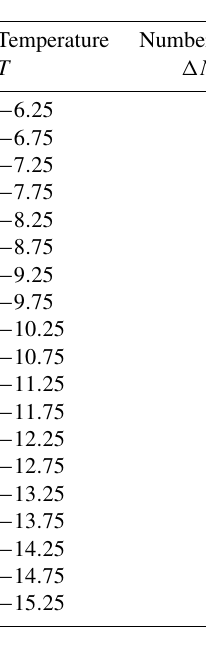
Table 3. Observed freezing data used as input to the Monte Carlo simulation described in Sect. 7.